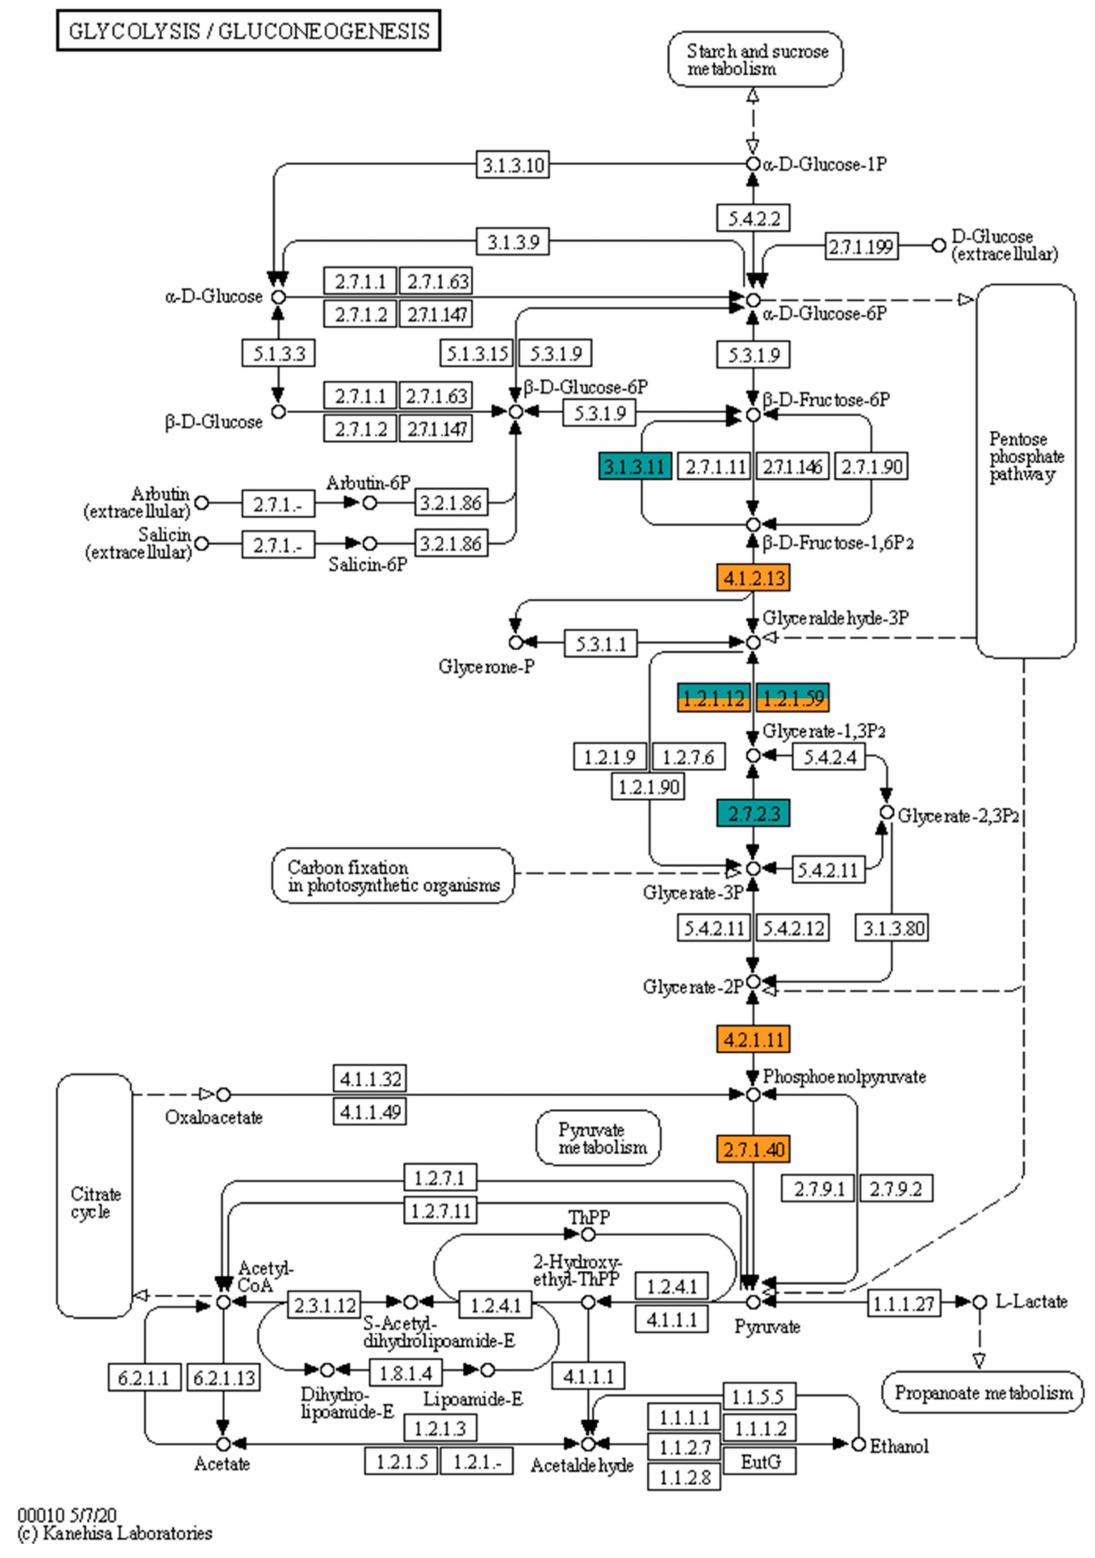
Figure 7. Molecular response in the glycolysis/gluconeogenesis pathway of Synechococcus sp. GFB01 cultured in BG-11 and BG-11 10%N . In orange are enzymes expressed in both conditions, and in dark green BG-11 exclusive proteins. Proteins EC: 1.2.1.12 and EC: 1.2.1.59 were detected as five sequences not shared by the two conditions tested, three in BG-11. Image based on the KEGG